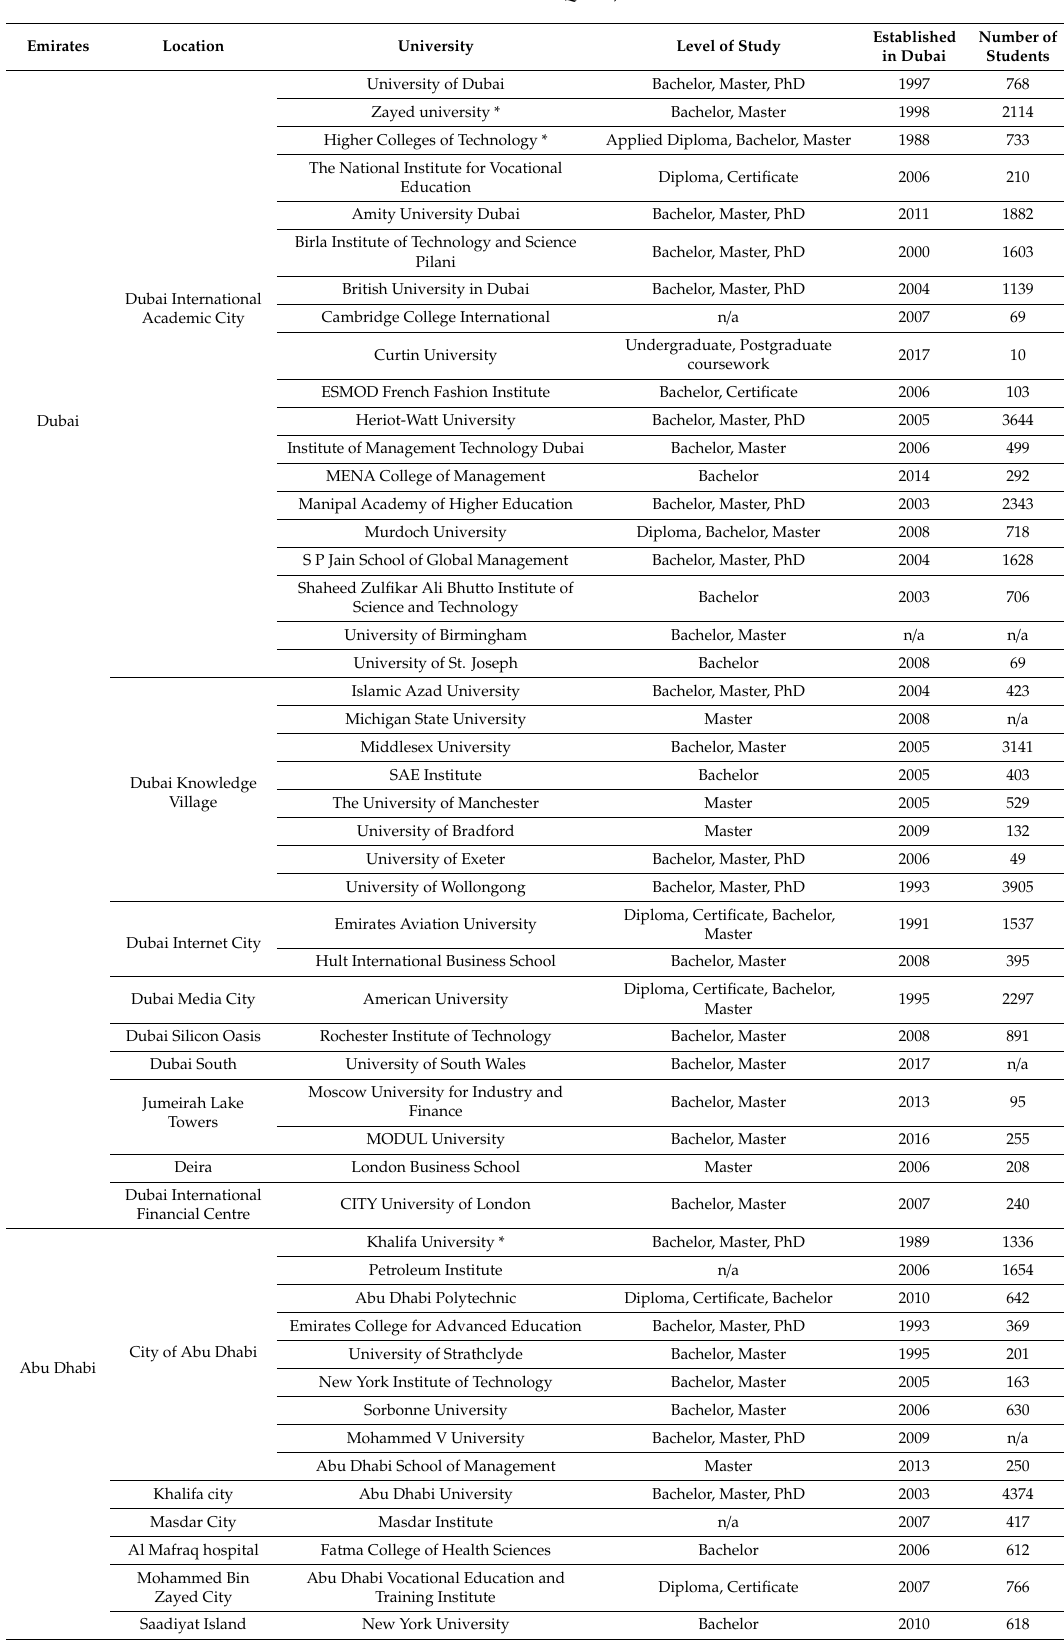
Table 4. Academic institutions in Qatar, Abu Dhabi and